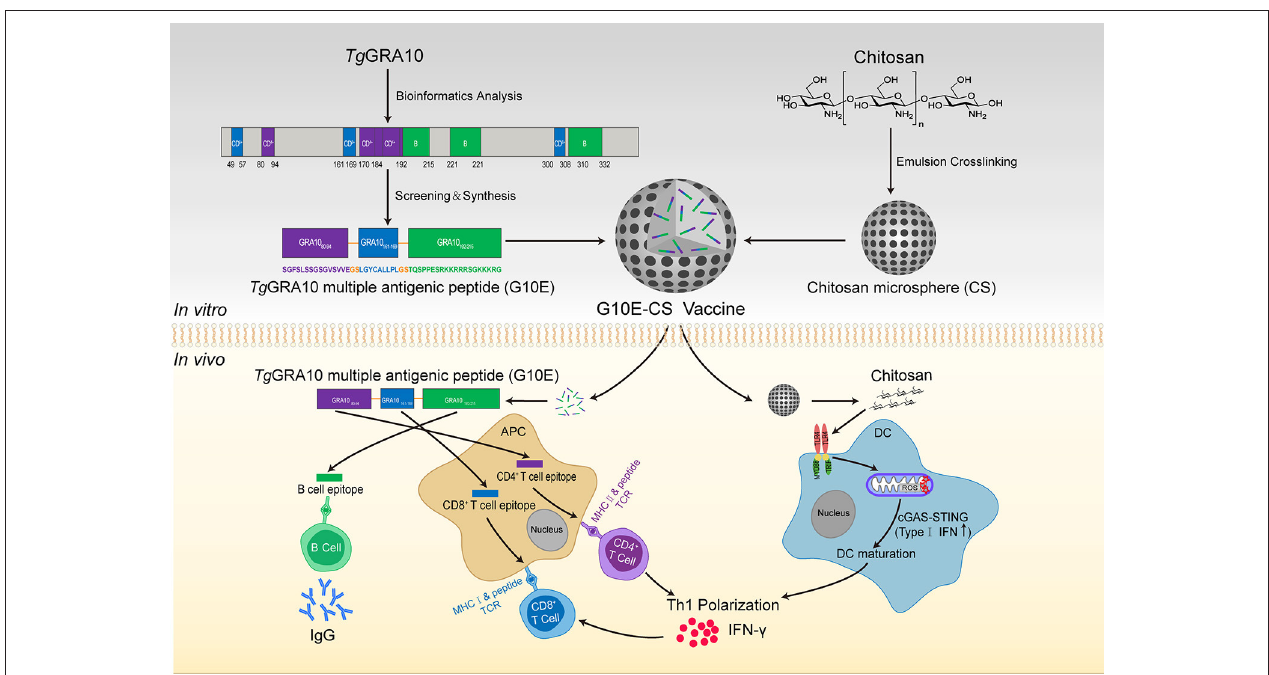
FIGURE 1 | Construction of T. gondii G10E-CS vaccine and potential immune mechanism involved in vaccination with G10E-CS in vivo . In this study, dominant B cell, CD8 + and CD4 + T cell epitopes from GRA10 protein of T. gondii were selected by bioinformatics and immunological analysis. Then the G10E-CS microsphere vaccine formed by three dominant epitopes and linked by sequence GS was loaded onto chitosan microspheres by emulsion cross-linking method. When BALB/c mice were immunized with G10E-CS, the G10E peptides released from the microspheres induced specific humoral and cellular response. At the same time, chitosan as an attractive adjuvant could induce activation of dendritic cells (DCs) via cGAS-STING signaling pathway and then promote T helper 1 (Th1) cellular immune